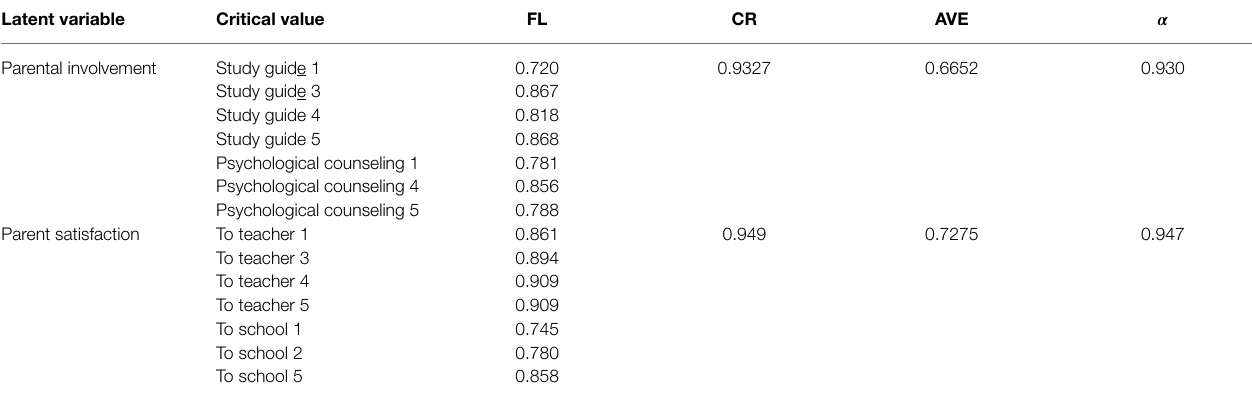
TABLE 3 | Reliability of the model.